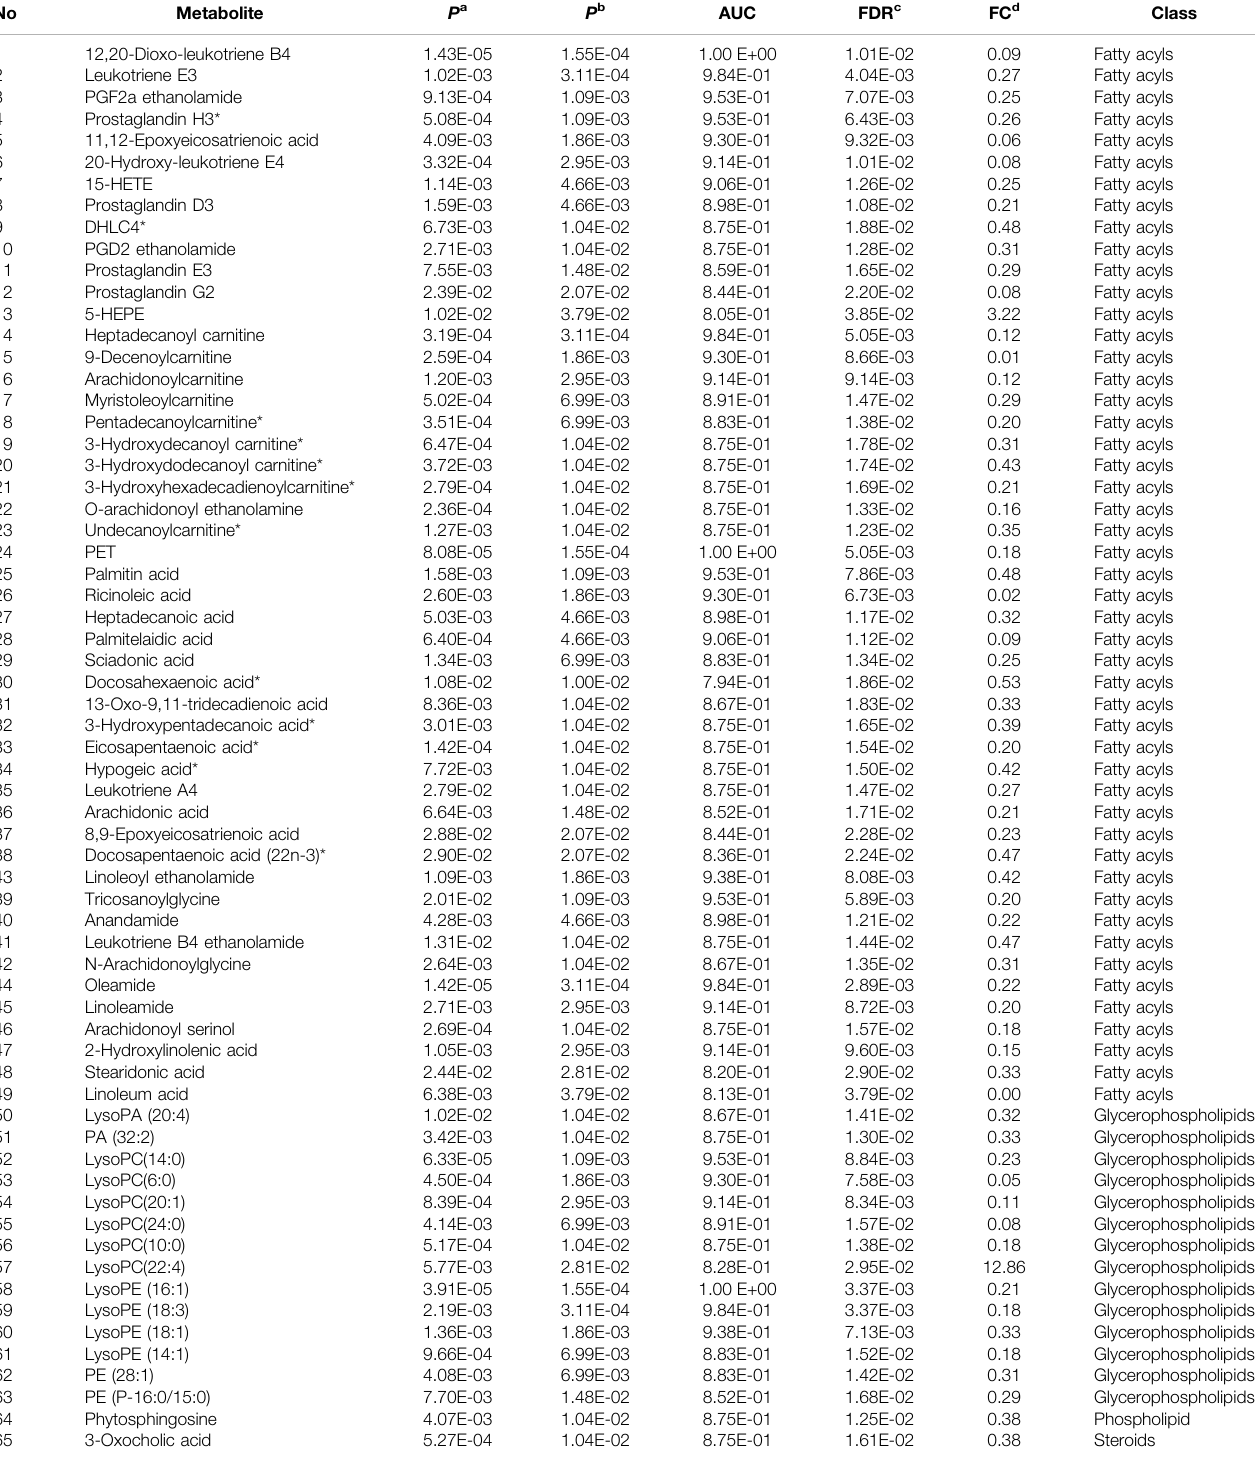
TABLE 1 | Identi fi cation of differential lipid species in kidney tissues of control and adenine-induced CRF rats.